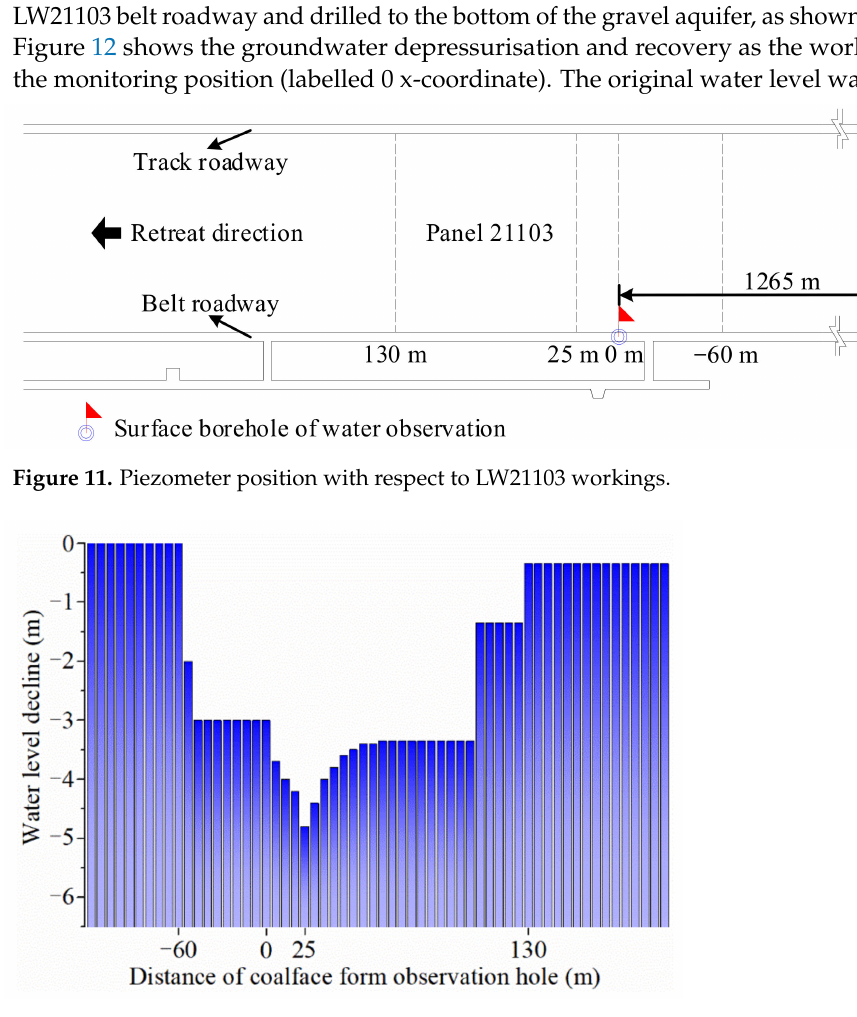
Figure 12. Groundwater level variation with longwall